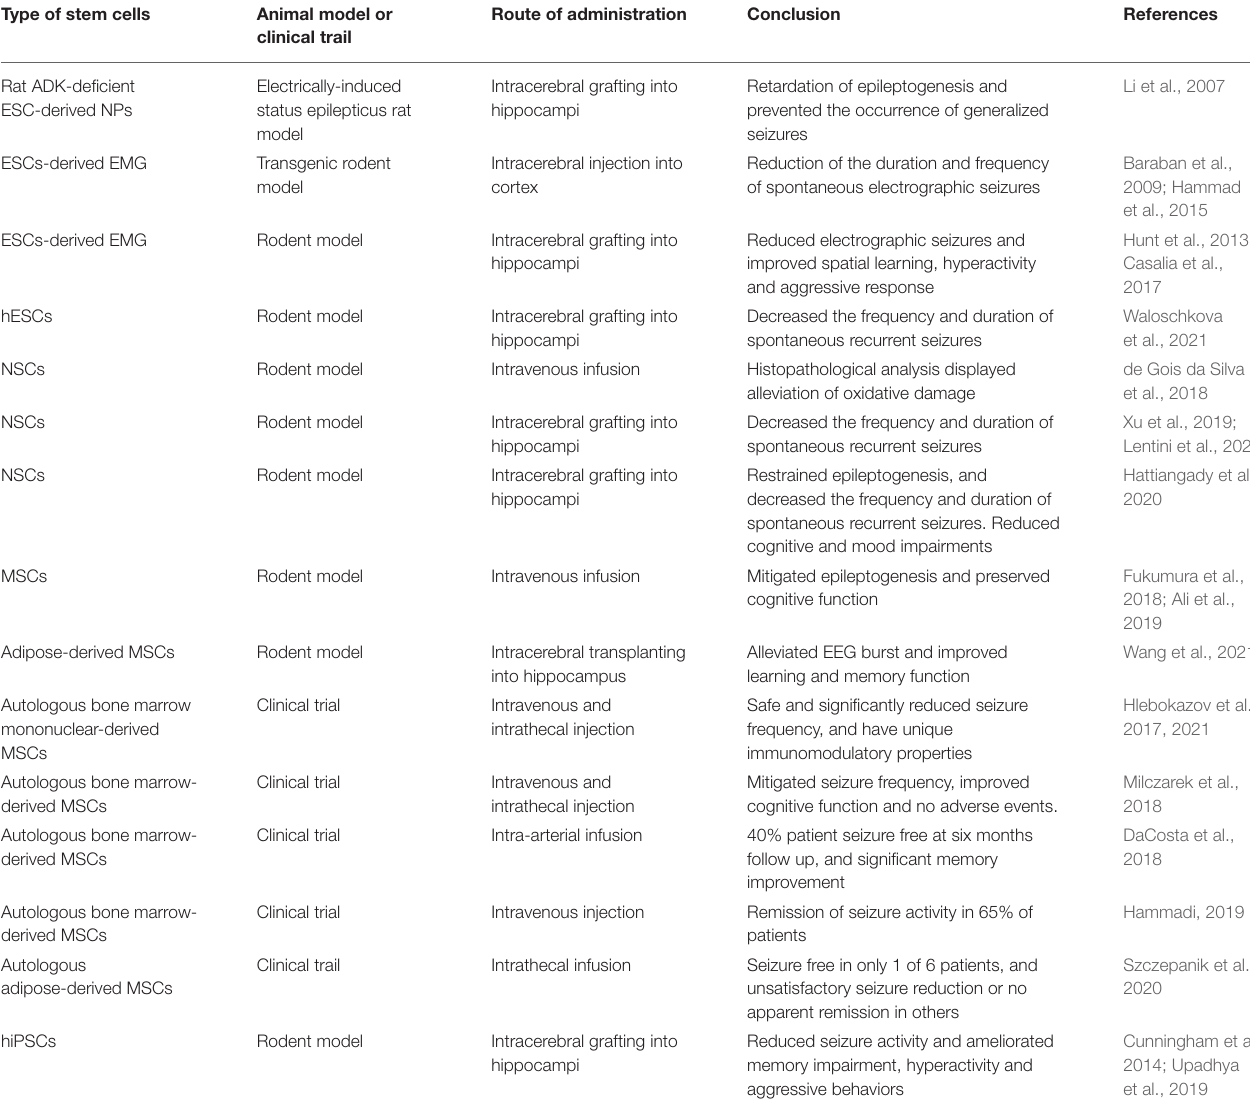
TABLE 1 | Preclinical and clinical studies of stem cell therapy for